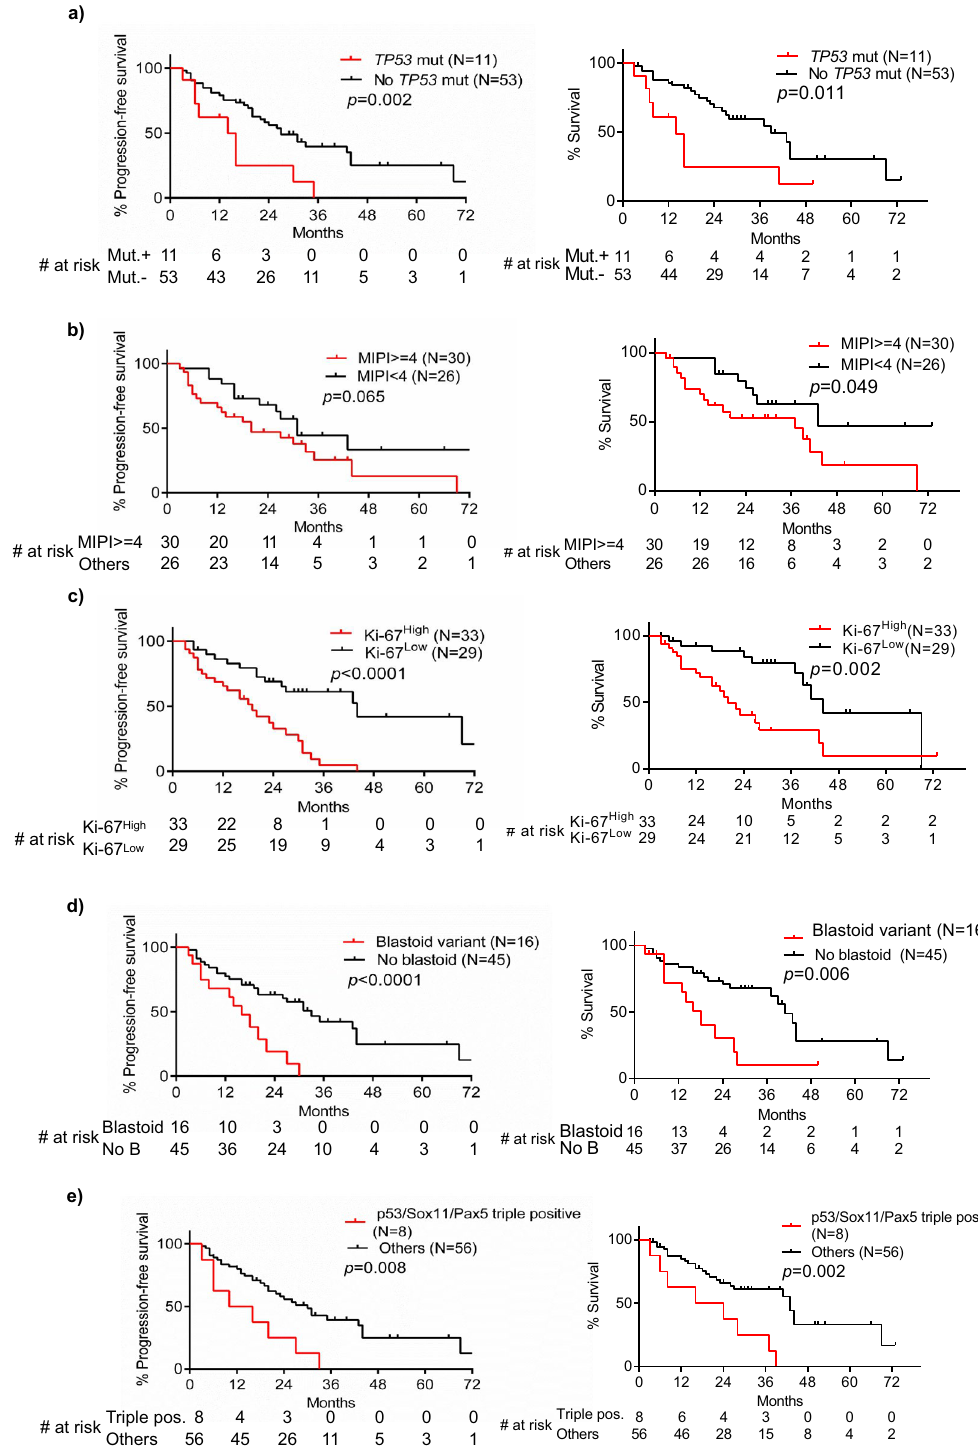
Figure 4. Risk factors of mantle cell lymphoma. ( a ) of 64 MCL patients, the median PFS was 14 versus 27 months (hazard ratio 2.657, 95% CI of ratio 1.595–12.78, p = 0.002) and the median OS was 14 versus 39 months (hazard ratio 2.663, 95% CI of ratio 1.408–13.09, p = 0.011) for TP53 mut+ versus the others; ( b ) the median PFS was 20 versus 31 months (hazard ratio 1.791, 95% CI of ratio 0.9221– 3.544, p = 0.065) and the median OS was 37 versus 43 months (hazard ratio 2.186, 95% CI of ratio 1.014–4.739, p = 0.049) for MIPI ≥ 4 patients versus the others; ( c ) the median PFS was 19 versus 44 months (hazard ratio 3.19, 95% CI of ratio 2.015–7.286, p < 0.0001) and the median OS was 20 versus 44 months (hazard ratio 2.934, 95% CI of ratio 1.545–6.441, p = 0.002) for Ki-67 high patients versus the others; ( d ) the median PFS was 16 versus 33 months (hazard ratio 2.816, 95% CI of ratio 2.007–11.6, p < 0.0001) and the median OS was 18 versus 41 months (hazard ratio 2.616, 95% CI of ratio 1.514–9.706, p = 0.006) for patients with blastoid variant cells versus the others. Three patients’ blastoid variant information was not available. ( e ) The median PFS was 13 versus 30 months (hazard ratio 2.794, 95% CI of ratio 1.661–15.9, p = 0.008) and the median OS was 20 versus 43 months (hazard ratio 3.210, 95% CI of ratio 2.067–22.26, p = 0.002) for triple-positive patients versus the